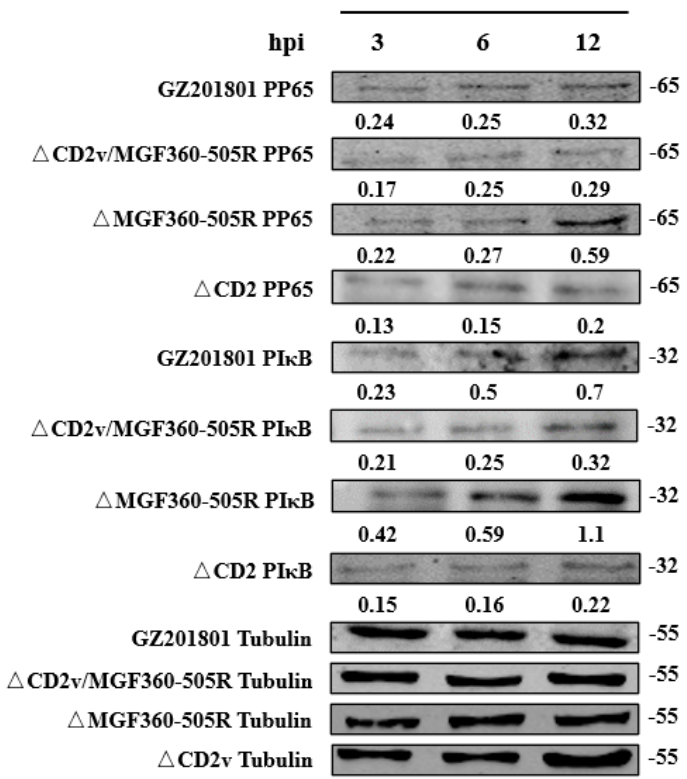
Figure 4. NF- κ B signaling pathway analysis after ASFV infection. Western blotting was used to measure the expression of PP65 and PI κ B protein at 3, 6, and 12 h in each group of GZ201801-ASFV-, Δ MGF360-505R-ASFV-, Δ CD2v-ASFV-, and Δ CD2v/ Δ MGF360-505R-ASFV-infected PAMs. Expression of tubulin was used as a positive control. PAMs were either infected with GZ201801-ASFV or Δ CD2v/ Δ MGF360-505R-ASFV at a MOI of 0.1 .